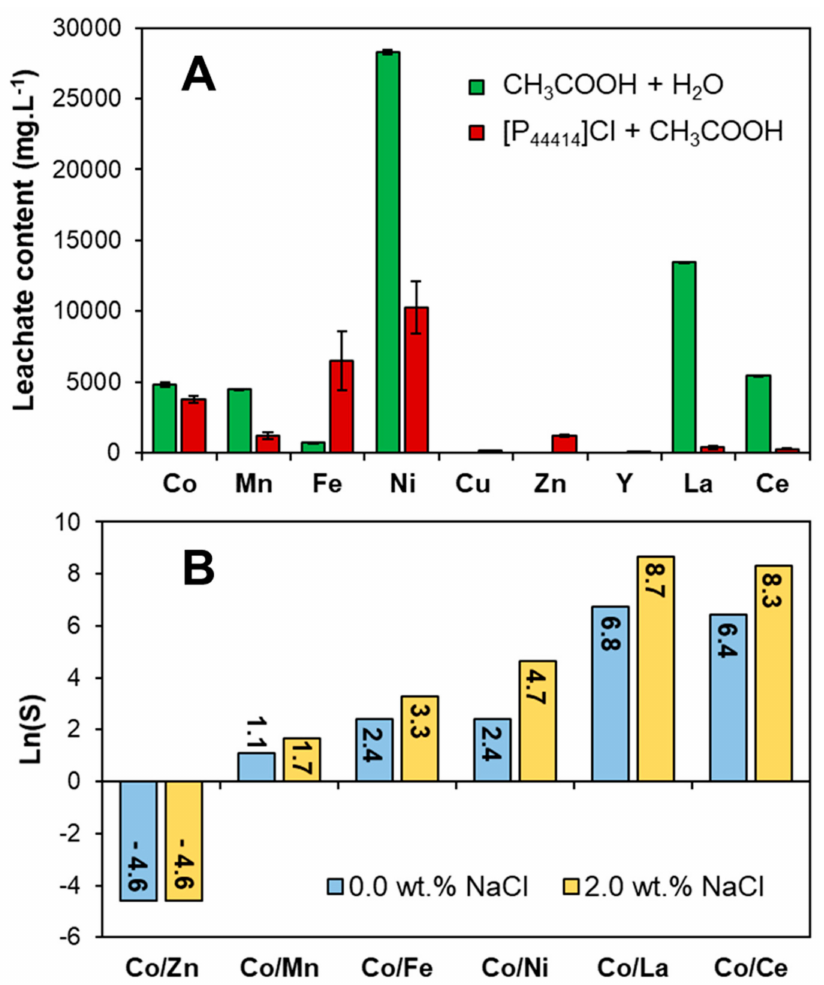
Figure 6. ( A ) Metal concentration in the NiMH battery leachate composed of 27.0 wt.% CH3COOH aqueous solution and in the 73.0 wt.% [P 44414 ]Cl + 27.0 wt.% CH 3 COOH mixture (t = 24 h, T = 323 K, S / L = 0.1). ( B ) Co(II) selectivity (S) in the biphasic [P 44414 ]Cl + CH 3 COOH + H 2 O from the